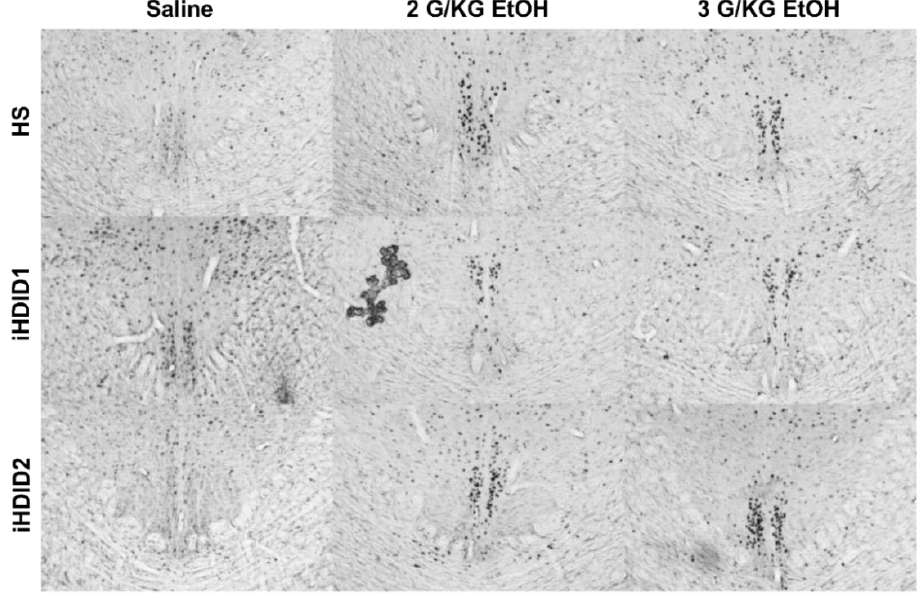
Figure 12. Edinger Westphal Nucleus. Representative images of c-Fos expression in the EW across genotype and treatment types.